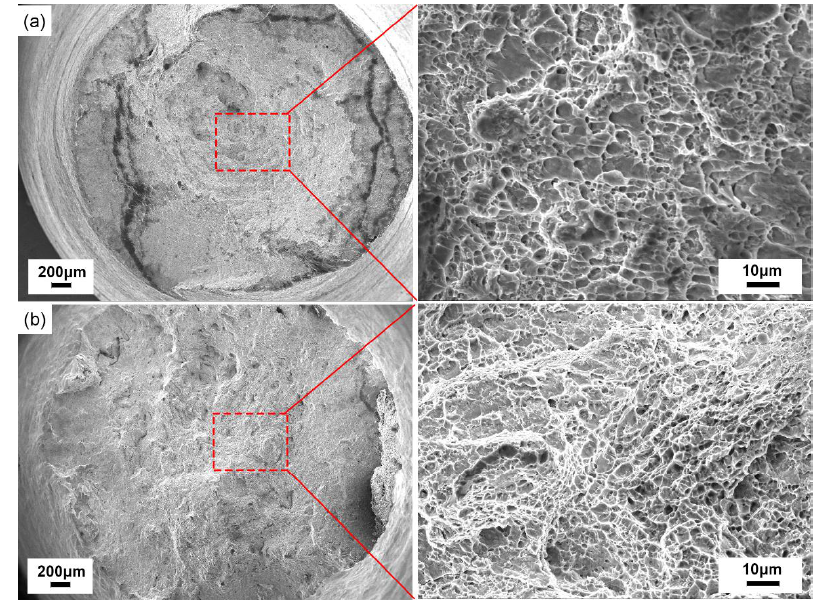
Figure 10. The tensile fracture morphology of the SA 508–3 samples ( a ) at 950 °C with a 30% reduction ratio holding for 10 h and ( b ) at 1150 °C with a 30% reduction ratio holding for 10